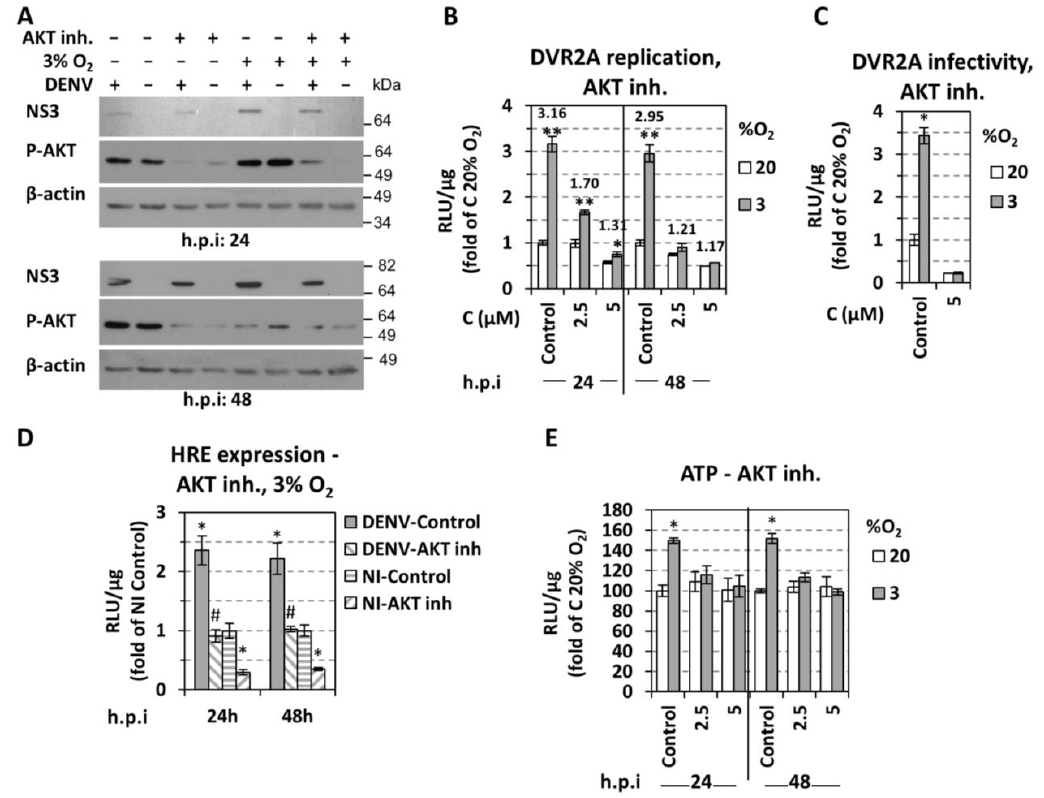
Figure 7. Effect of AKT inhibition on oxygen-regulated increase of DENV replication. ( A – E ) Huh7 cells, preincubated at 3% or 20% O 2 for 18 h, were infected with DENV (MOI 0.5) or DVR2A (MOI 0.1), or first transfected with the 9×HRE-Luc construct and 4 h later infected with DENV (MOI 0.5). Non-infected cells were used as control. After virus inoculation, the AKT inhibitor VIII was added at 5 μΜ, unless otherwise specified, and cells were further incubated at the pre-incubation conditions. ( A ) Western blot analysis of DENV NS3 (top), p-AKT (middle), and β-actin (bottom). The latter served as loading control. A